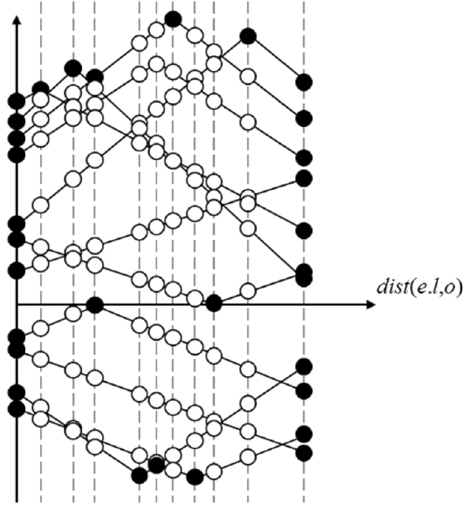
Figure 10. Example of dist ( o , p ) × CI ( Q , p ) on e .